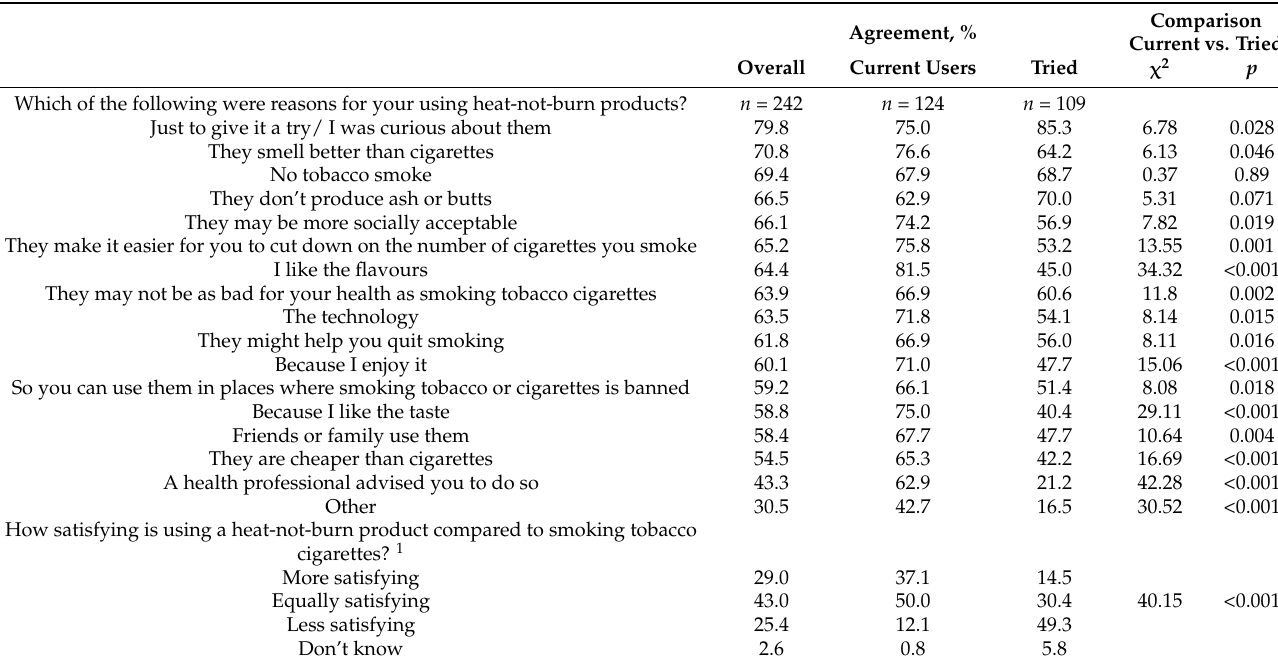
Table 3. Reasons for use of HTPs and satisfaction relative to smoking, n = 242 ever users.